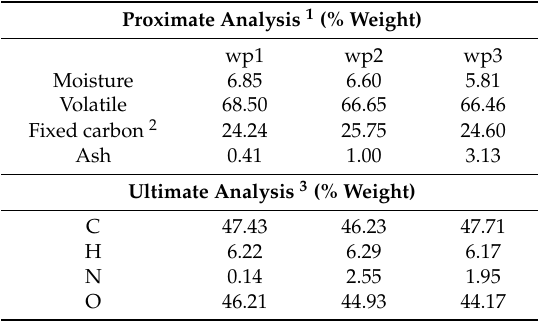
Table 1. Properties of the biomass fuels.